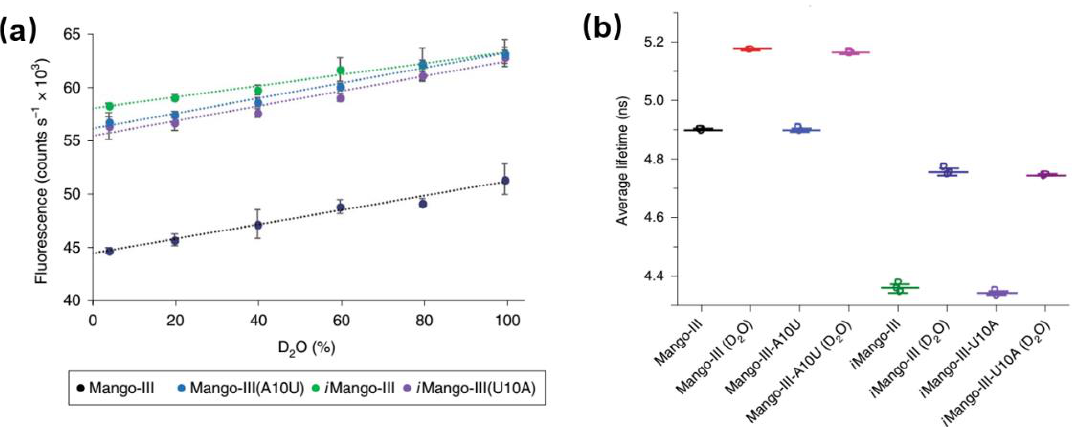
Figure 11. Photophysical properties of Mango-III and its several mutants. ( a ) Fluorescence intensity of four aptamer-TO1- Biotin complexes versus D 2 O percentage. ( b ) Fluorescence lifetime of four aptamer-TO1-Biotin complexes in pure water of 96.6% D 2 O. Image reproduced from Nature Chemical Biology 15 (2019) 472.